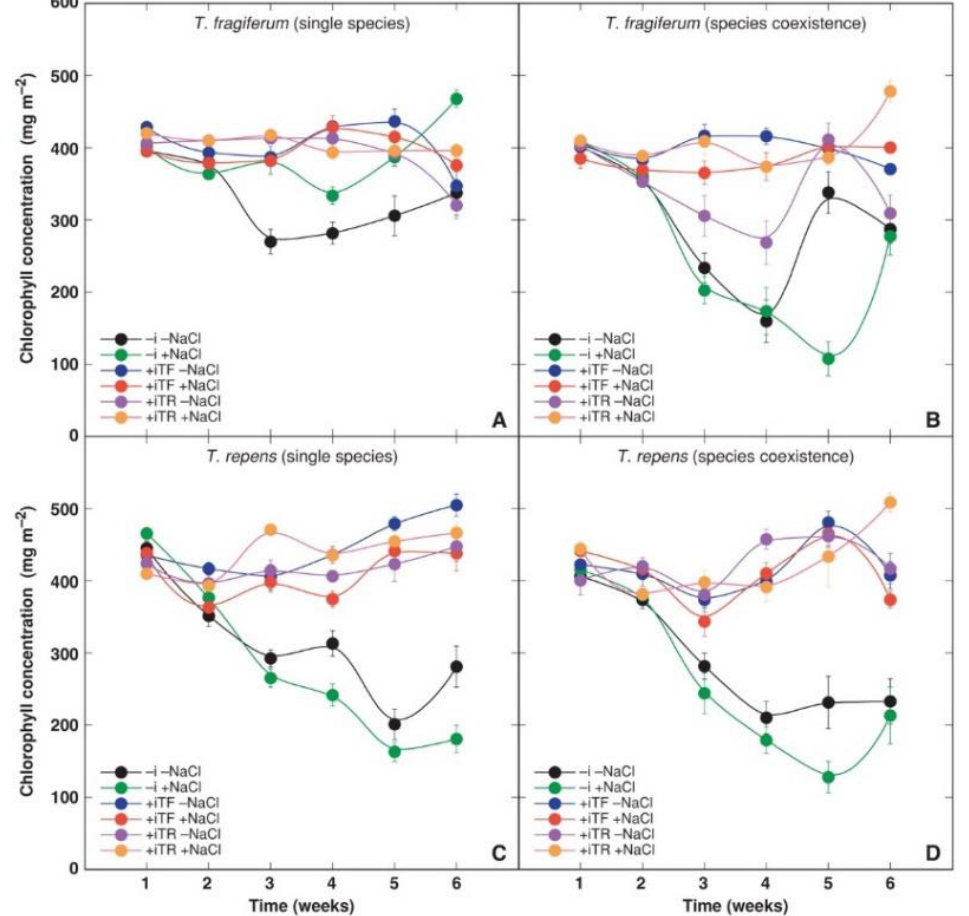
Figure 3. Time course of chlorophyll concentration in leaves of T. fragiferum in single species condi- tions ( A ), T. fragiferum in species coexistence conditions ( B ), T. repens in single species conditions ( C ), T. repens in species coexistence conditions ( D ). Each data point represents the mean from three randomly selected containers per treatment with three measurements per container ± SE. –i, without rhizobial inoculation; +iTF, inoculated with rhizobia from T. fragiferum ; +TR, inoculated with rhizobia from T. repens . Table 9. ANOVA analysis of leaf chlorophyll concentration and Performance Index.